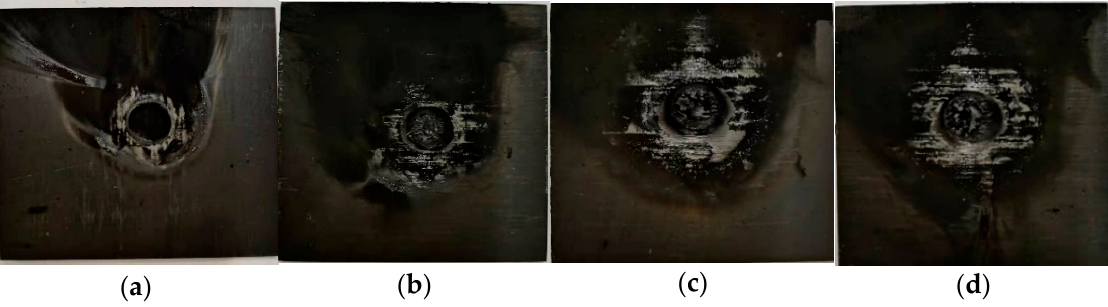
Figure 5. Ablation morphologies of CFRP laminates with different laser power. ( a ) 250 W; ( b ) 500 W; ( c ) 750 W; ( d ) 1000